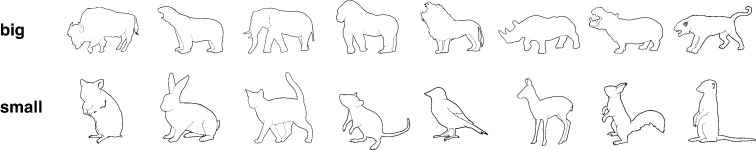
Visual stimuli showing either big or small animals.